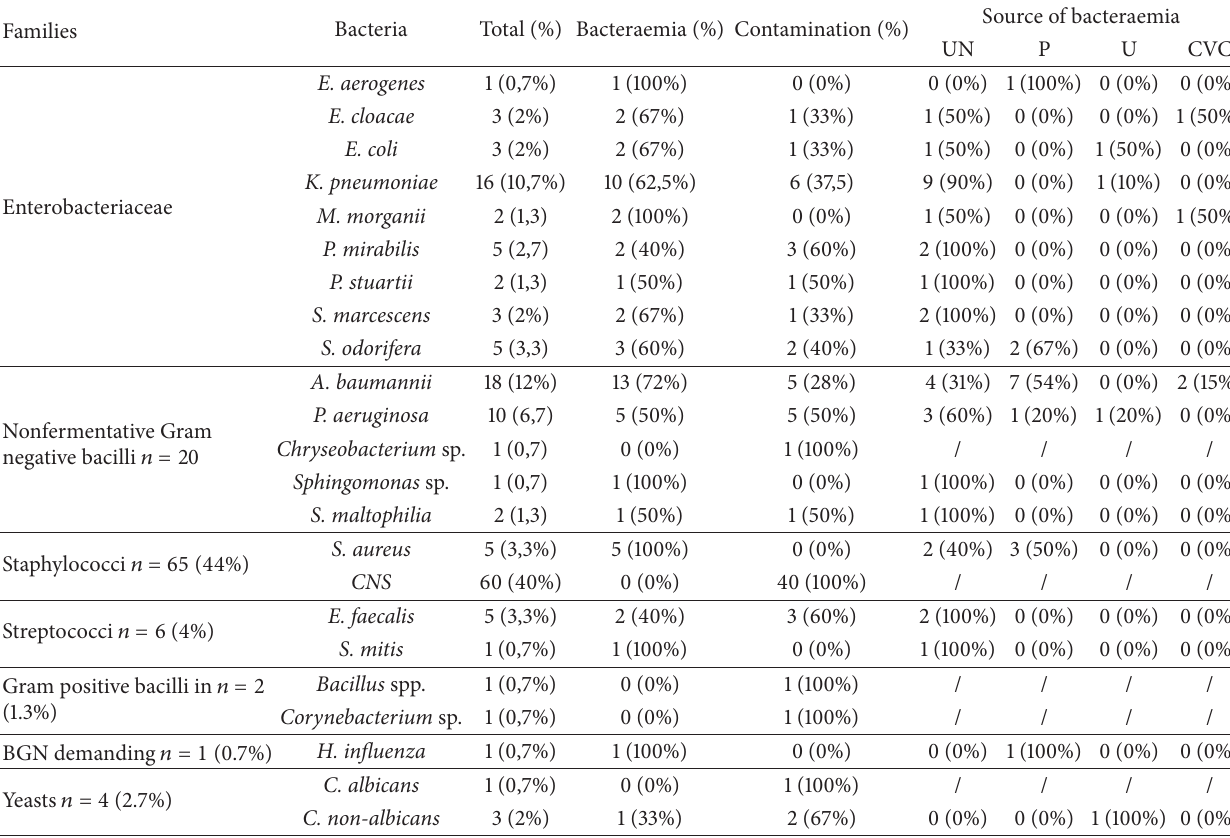
Table 2: Distribution of different isolates in relation to setting of source of bacteraemia.